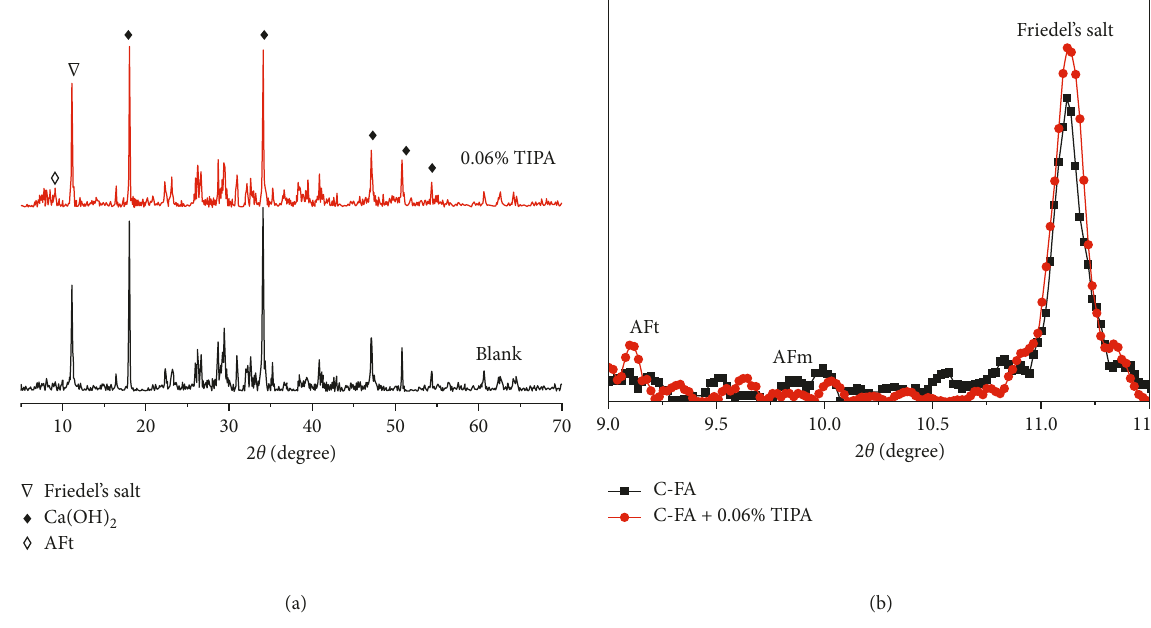
Figure 3: XRD patterns of cement-FA paste hydrated at 60 days.